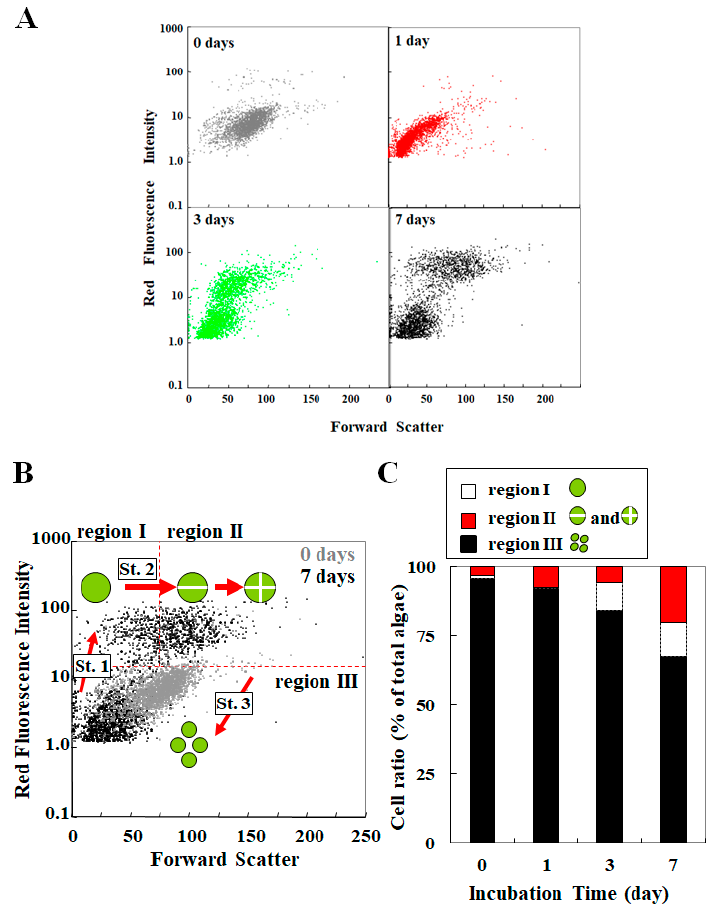
Figure 6. Demographic dynamics of endosymbiotic algae in P. bursaria using capillary FCM. ( A ) Scatter plots for forward scatter signals (FSS) vs. red fluorescence intensity are shown using data obtained from P. bursaria at different growth phases. It is noteworthy that the displayed signals include only data from endosymbiotic algae, but not from intact P. bursaria host cells. ( B ) A result of comparison among distributional patterns of endosymbionts is portrayed culture term by culture term. Based on algal optical properties related to the algal cell cycle, the distributional patterns of endosymbionts are classified into three populations (regions I–III). Here, labels denote the St. 1, “growth” stage; St. 2, “ripening” stage; and St. 3, “division and autospore liberation” stages. ( C ) Chronological changes of algal distribution patterns are estimated as the composite bar chart at each incubation time of P. bursaria . These panels ( A – C ) were referred from the literature